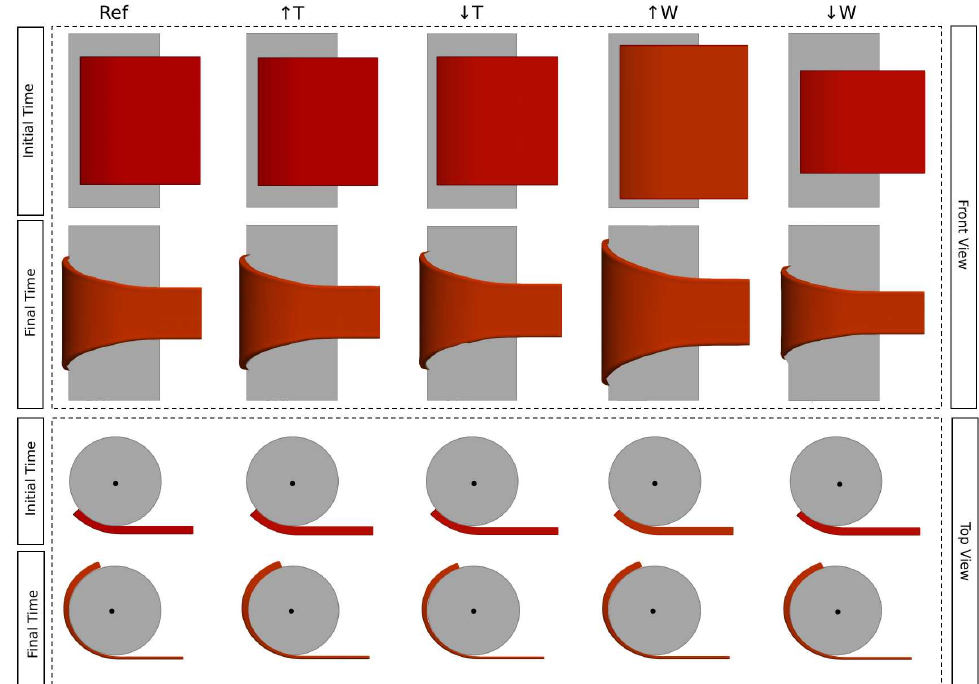
Figure 11. A schematic representation of the numerical results of the sample dimensions errors case studies compared to the reference one, Ref, at the initial and final times.